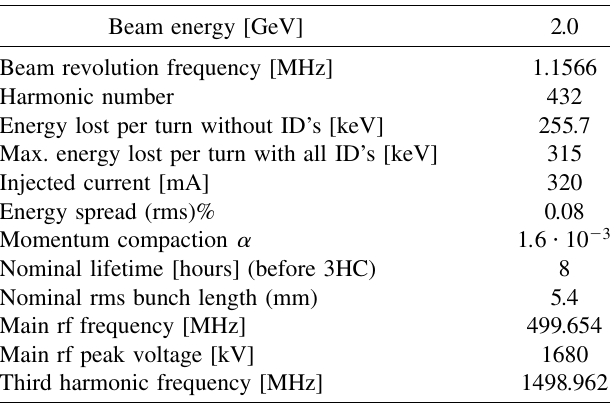
TABLE I. ELETTRA machine